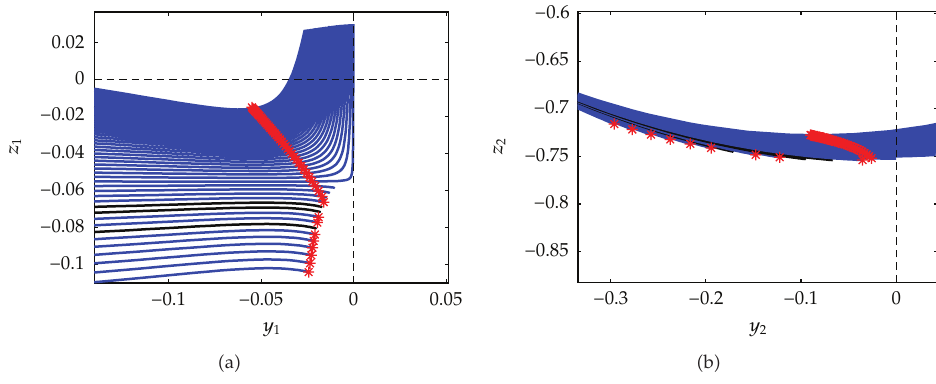
Figure 6: Zoom of the results of Figure